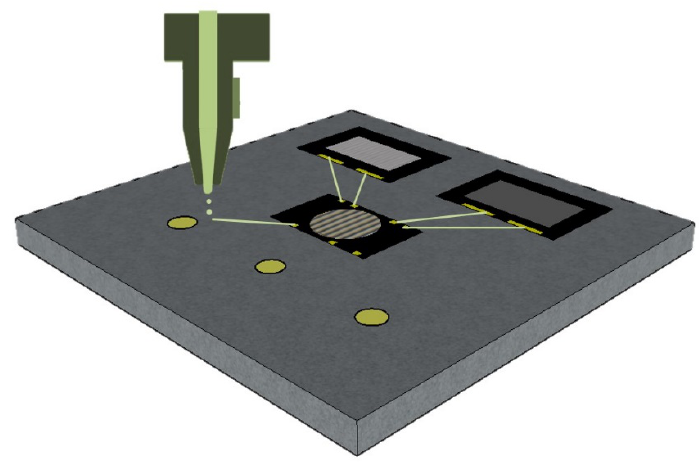
Figure 1. Schematic illustration of the fabrication process of redistribution layers in FOWLP by using drop-on-demand inkjet-printing.